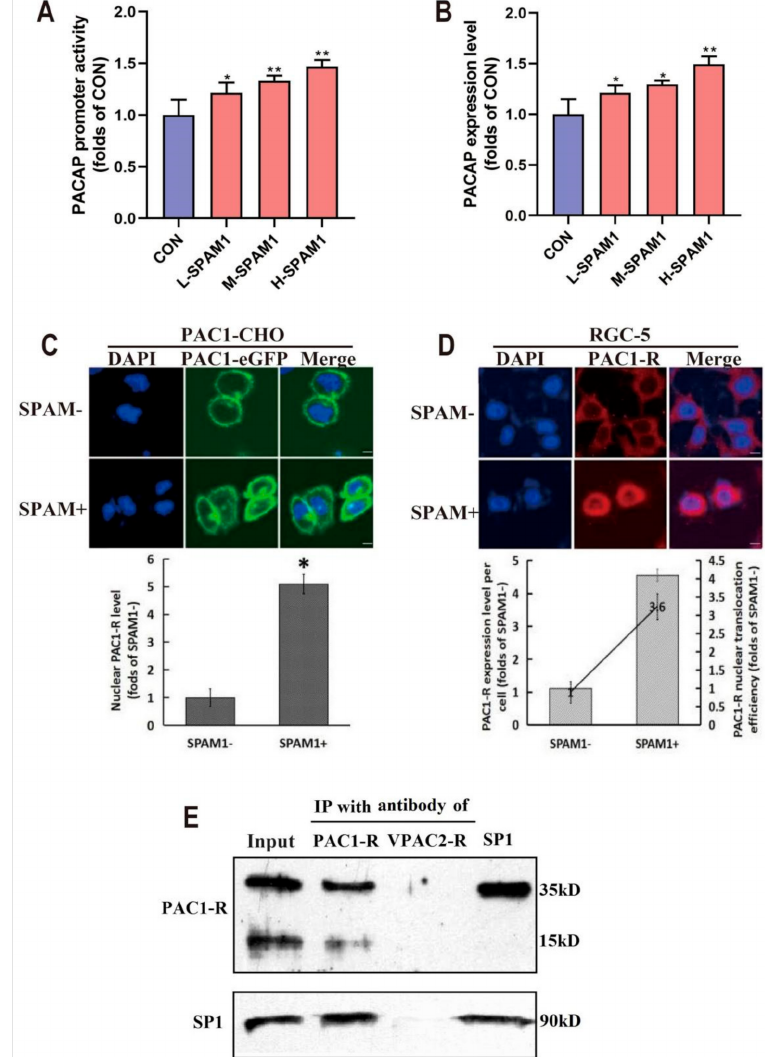
Figure 8. Effect of SPAM1 on the nuclear translocation of PAC1-R. ( A ) The dual-luciferases reporter assay result demonstrated that the promoter activity of PAC1-R is significantly enhanced by SPAM1 (0.01–1 µ M). ( B ) The ELISA result showed that SPAM1 (0.01–1 µ M) significantly increase the expres- sion level of PACAP in RGC-5 cells. ( C ) The effect of SPAM1 (1 uM) on the nuclear translocation of PAC1R-eGFP detected in PAC1R-CHO cells by fluorescence images ( up ) and corresponding sta- tistical analysis ( down ). Shown was SPAM1 (1 uM) inducing significant traffic and aggregation of PAC1R-eGFP fluorescence signal (green) into the nucleus. ( D ) Immunofluorescence images with the antibody targeting the C-terminus of PAC1-R ( up ) and the related statistical analysis of PAC1-R signals ( down ) in the RGC-5 cells treated with SPAM1 (1 uM). In the statistical analysis ( down ), the line with the left axis represents the PAC1-R expression level per cell and the column with the right axis indicated PAC1-R nuclear translocation efficiency. It was demonstrated that SPAM1 (1 uM) significantly up-regulated the expression of PAC1-R associated with the nuclear translocation of PAC1-R. ( E ) The Co-IP assay result detected the positive signal of SP1 in pulling down with the PAC1-R C-terminal antibody; meanwhile, no PAC1-R signal or SP1 signal was detected in pulling down with VPAC2-R antibody, indicating that nuclear PAC1-R can directly interact with SP1. The Re-IP assay result only detected a positive signal of 35 kDa of PAC1-R in pulling down with SP1 antibody, which indicate 35 kDa but not 15 kDa fragments of PAC1-R directly interact with SP1. *, p < 0.05, vs. CON; **, p < 0.01 vs. CON. Data are presented as the mean ± SEM of three experiments (Scale bars, 5